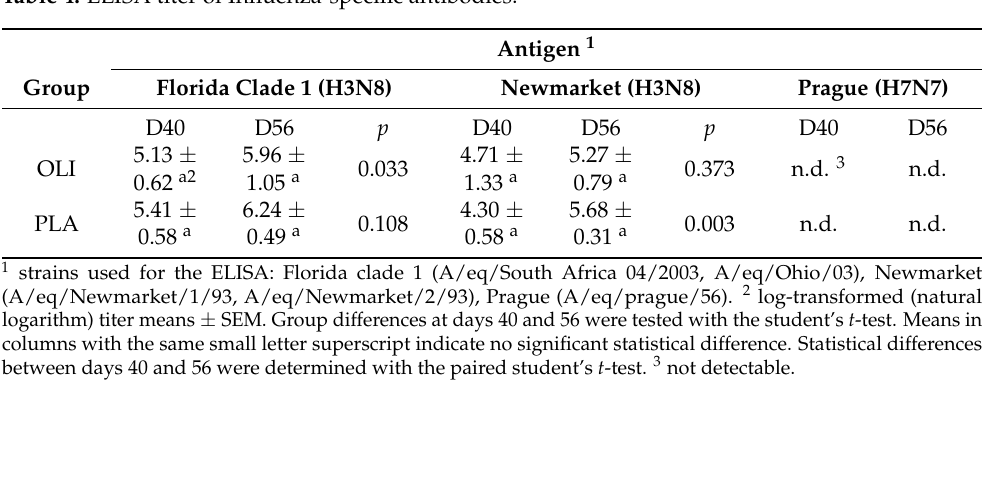
Figure 3. Spider diagram showing fold changes of blood cell populations within 24 h after vaccination. On the day of challenge (d40), horses of both groups had comparable ELISA antibody levels against H3/N8 influenza. Before and after vaccination antibodies against a H7/N7 strain were not detectable (Table 3). Sixteen days after vaccination horses of both groups showed a numerical increase in ELISA titers against H3/N8 strains. In the OLI group the increase reached significance for antibodies against Florida Clade 1 (H3/N8), in the PLA group a significant titer increase was noted for antibodies against Newmarket 2/93 (H3/N8) (Table 4). Table 4. ELISA titer of Influenza-specific